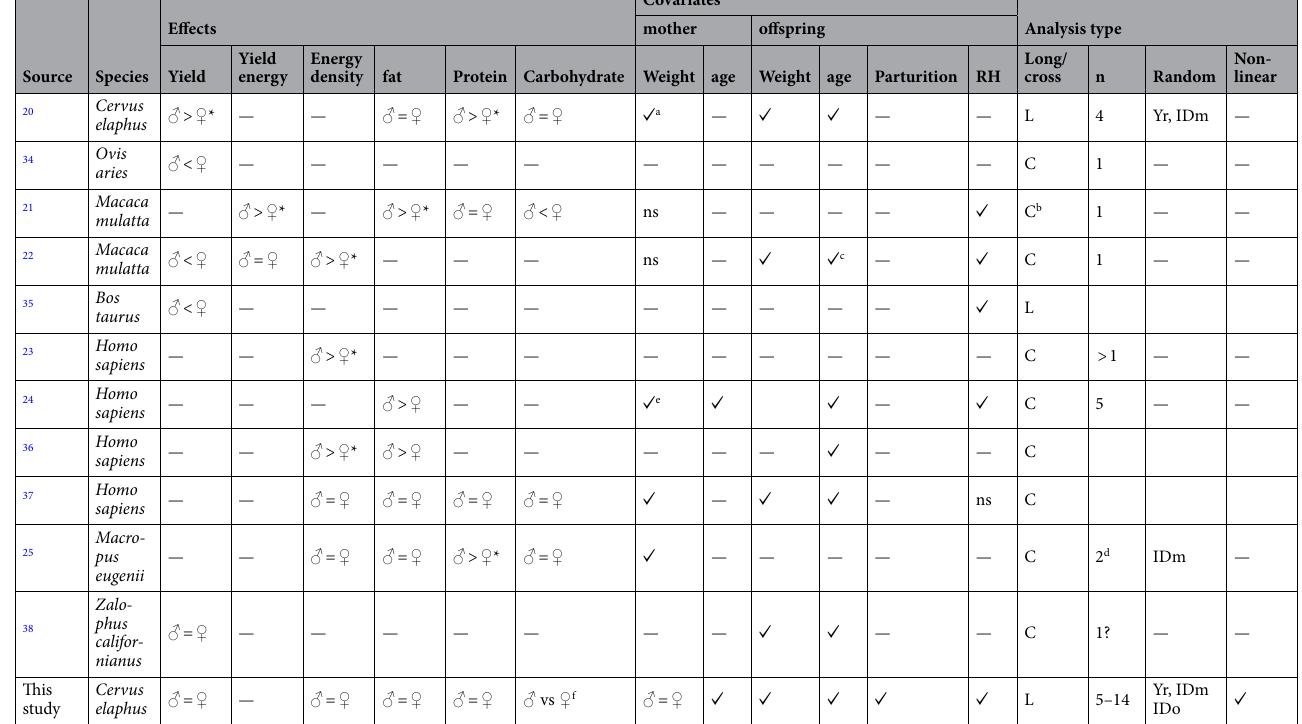
Table 3. Summary of studies in the literature that analysed milk provisioning, indicating the type of analysis, effects and covariates used. a Mother weight after giving birth, it does not account for mother weight changes across lactation. b Primiparous vs multiparous. c Age at peak of lactation, this is only one age record within offspring. d Two phases of lactation. e Body condition index. f Complex interaction. *Supporting differential allocation of resources offspring sex-dependent. Yield: milk yield; yield energy: energy provided by milk yield; fat, protein and carbohydrate content in milk; weigth: body weight; parturition: parturition date; RH: maternal reproductive life history (parity); long/cross: longitudinal (L) or cross-sectional (C) population analysis; n: number of milking events across lactation; random: random effects when a linear mixed model was used; IDo: offspring ID; IDm: mother ID; Yr: year effect; ♀ : daughter; ♂ : son; ✓ : variable included in the analysis;